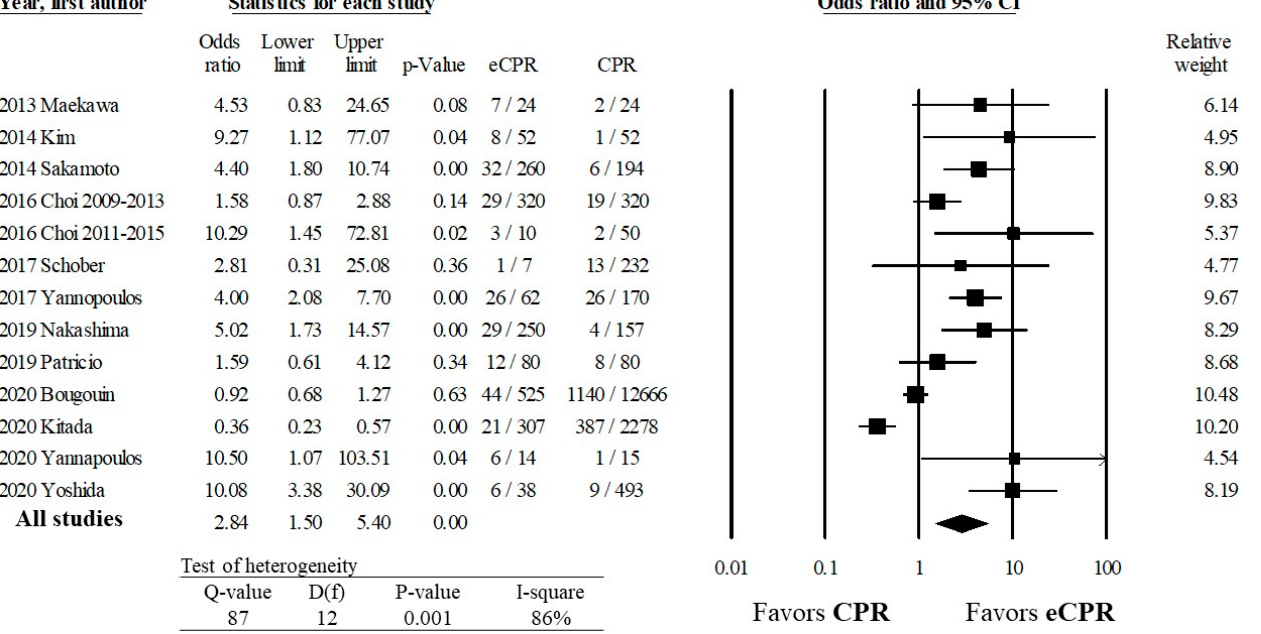
Figure 2. Association of ECPR and conventional CPR with any favorable outcome, defined as survival to hospital discharge or favorable neurologic function at hospital discharge or 30 or more days after cardiac arrest, among patients with OHCA. Abbreviations: CPR, cardiopulmonary resuscitation; ECPR, extracorporeal pulmonary resuscitation; OHCA, out-of-hospital cardiac arrest.